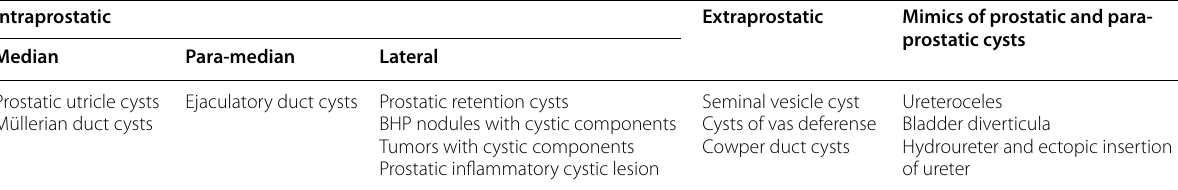
Table 1 Lower male genitourinary tract cystic lesions (source: Reference [5])